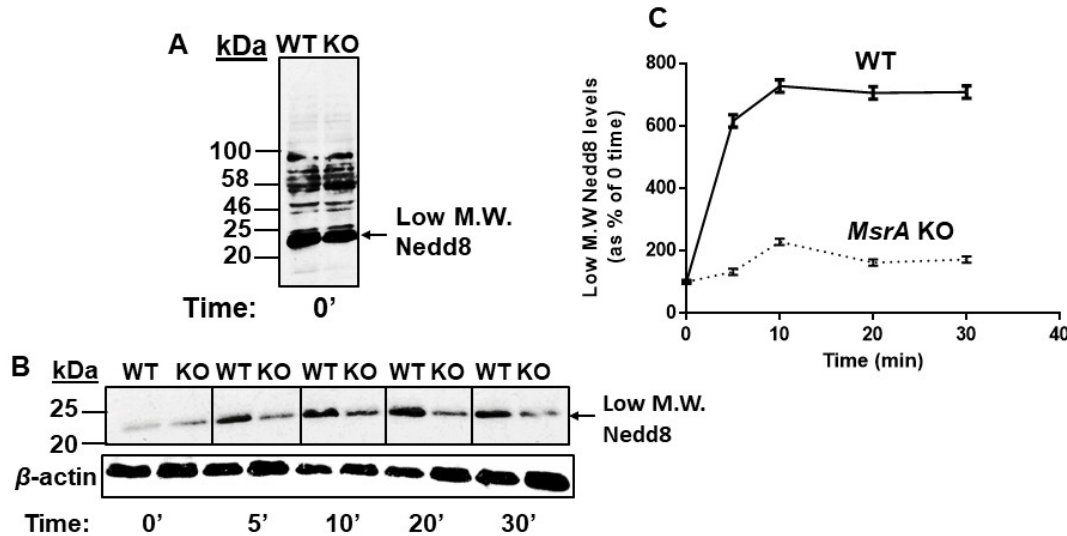
Figure 5. MsrA alters the kinetics of Jab1 deneddylase activity in vitro. (A) Western blot pattern of control group (time 0′). Total protein neddylation and Nedd8 levels are shown using the primary anti-His antibody. We focused on lowest molecular weight Nedd8 positive bands (Low M.W.Nedd8) as they represent the best end-product of the Nedd8 conjugates through the deneddylation process. ( B ) Quantification of lowest molecular weight Nedd8 positive bands at different time points following incubation with WT and MsrA KO mouse brain extracts ( n = 3, females, 6 months old). ( C ) Time curve of lowest molecular weight Nedd8 levels. All data were normalized to 0 min time. The shown WB are representatives of three repeated experiments. WT, Wild-type; KO, MsrA knockout; The difference between the two animal groups was statistically significant from the 5–30 min time points ( t -test, p < 0.001).